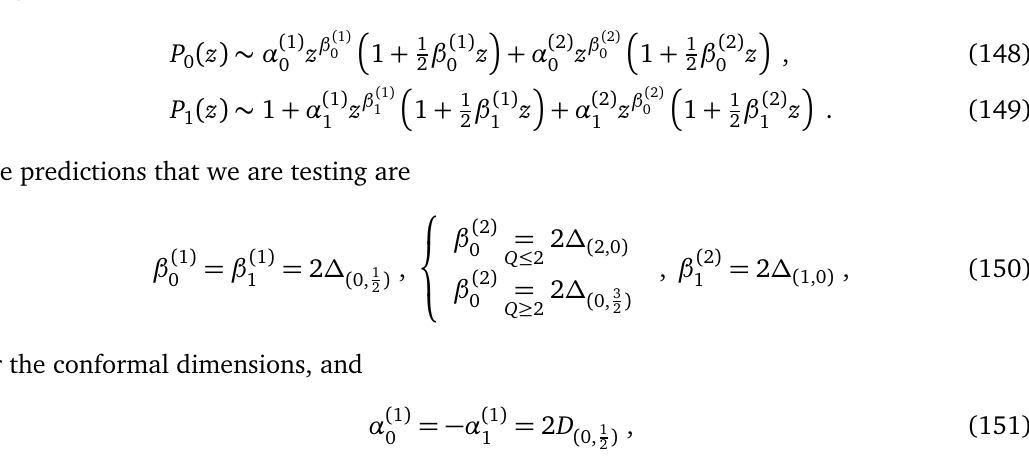
( z ) and P ( z ) . We show error bars in parentheses 0 1